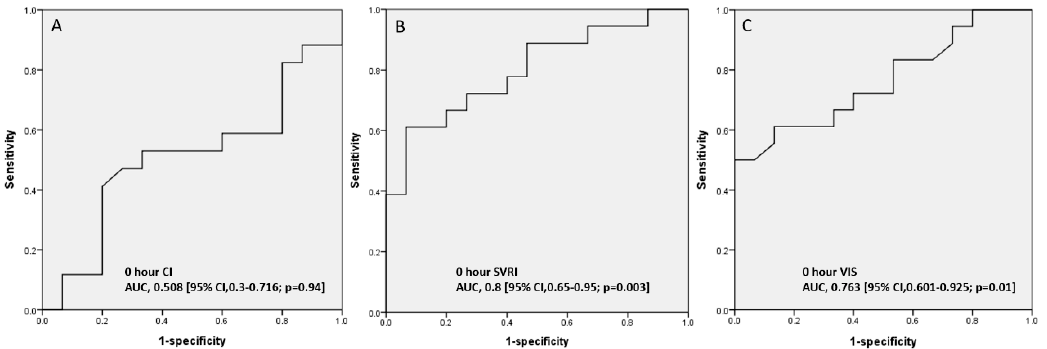
Figure 5. Predicting 28-day mortality at 0 h based on the AUCs of CI, SVRI, and VIS. ( A ) CI, ( B ) SVRI, and ( C ) VIS.